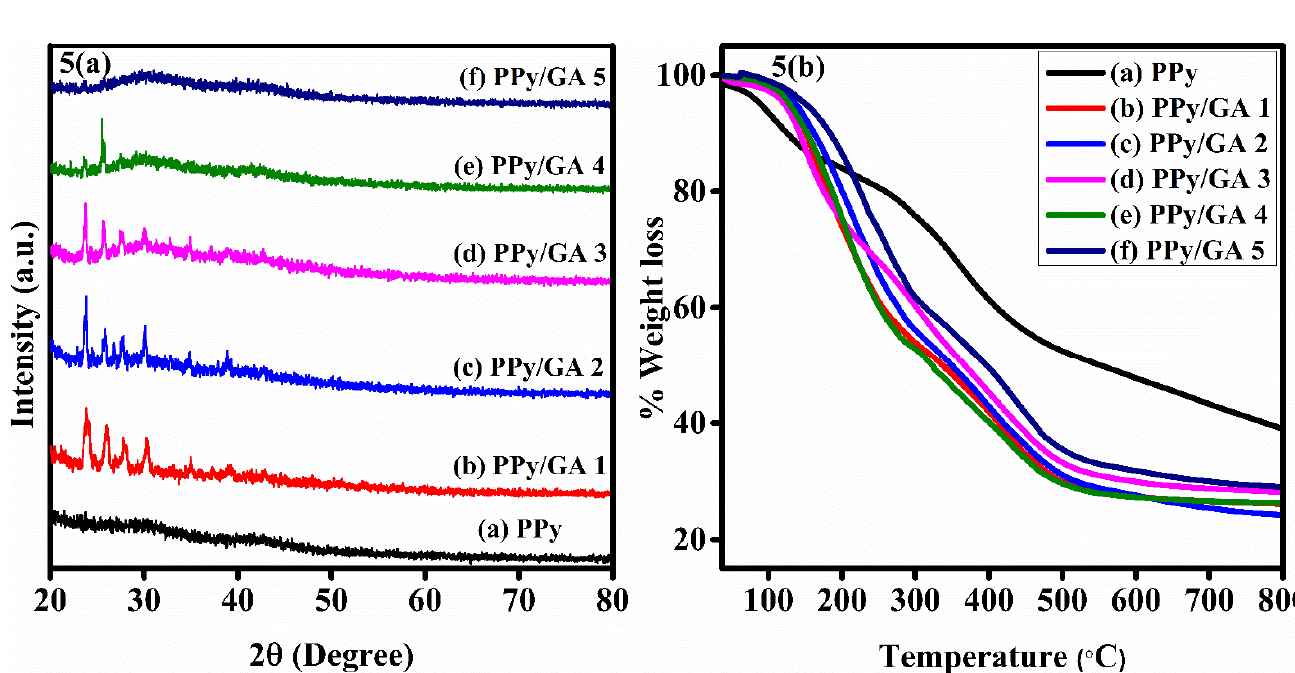
Figure 5. ( a ) XRD peaks of neat polypyrrole and its composites with gum arabic. ( b ) TGA of neat polypyrrole and its composites with gum arabic. polypyrrole and its composites with gum